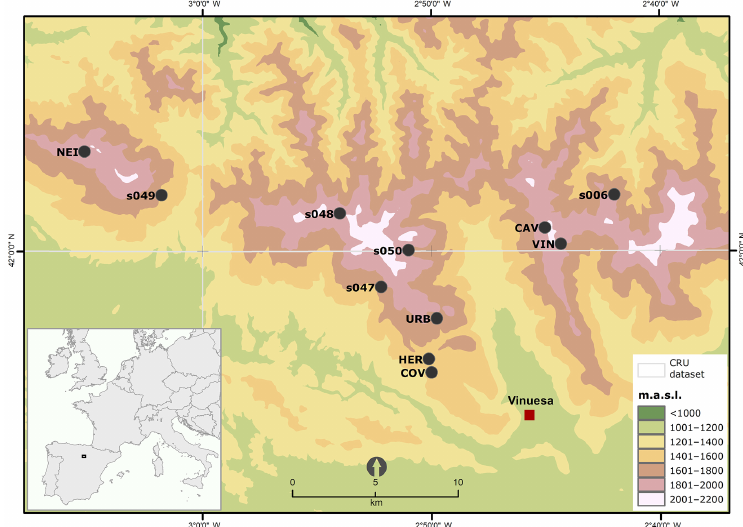
Figure 1. Map showing the tree-ring study sites and the climate data (CRU TS v.3.22) grid points in the western Iberian Range